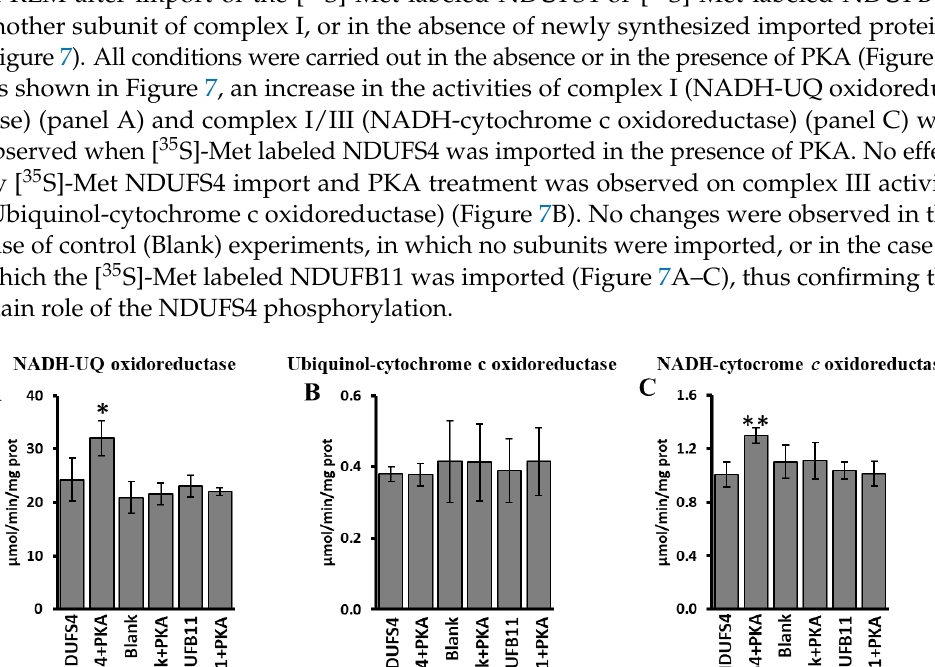
Figure 8. PKA addition to mitochondrial import experiments increased the complex I-supporting respiration. RRL translation mixtures containing newly synthesized [ 35 S]-Met-labeled NDUFS4 pro- tein or no protein present (Blank) were added to the import mixture containing RLM in absence and in the presence of PKA. After 60 min incubation at 30 °C, mitochondria were spun down from the import mixture and used to measure the oxygen consumption rates. ( A ) Oxygen consumption rates using pyruvate/malate (P/M) as substrate. ( B ) Oxygen consumption rates using succinate as sub- strate. The values are the means ± SD of three different experiments. (NDUFS4 + PKA vs. NDUFS4, * p < 0.05, Student’s t -test). For more details, see under Materials and Methods.